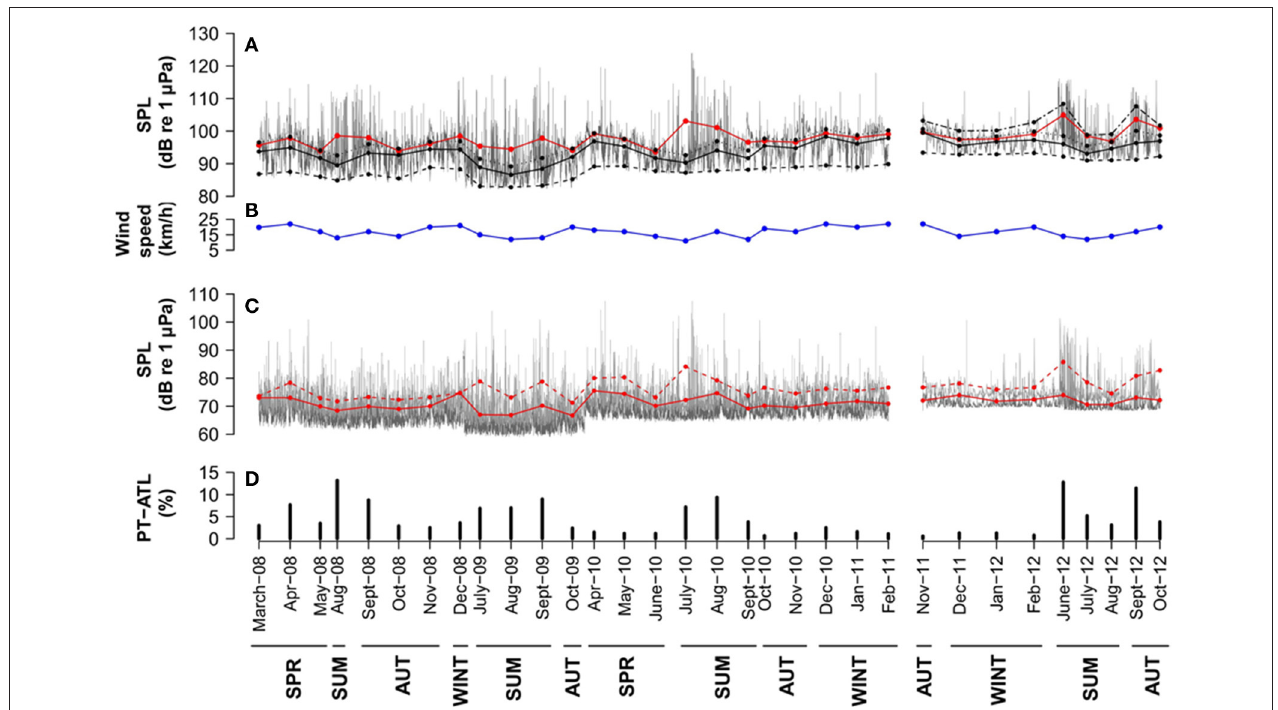
FIGURE 5 | Condor seamount: (A) hourly (gray lines) and monthly averages (red lines), medians (black lines) and 5th, 75th, and 95th percentiles (dashed black lines from bottom to top) SPLs in the 18–1,000Hz frequency band. (B) monthly averaged wind speed (blue line). (C) hourly SPLs in the 63Hz (dark gray lines) and 125Hz (light gray lines) one-third octave bands and monthly averages (63Hz: red line and 125 Hz: dashed red line). (D) monthly PT-ATL. Months are grouped in seasons below the x axis. Seasons are described as follows: SPR, Spring (March–May); SUM, Summer (June–August); AUT, Autumn (September–November) and WINT, Winter